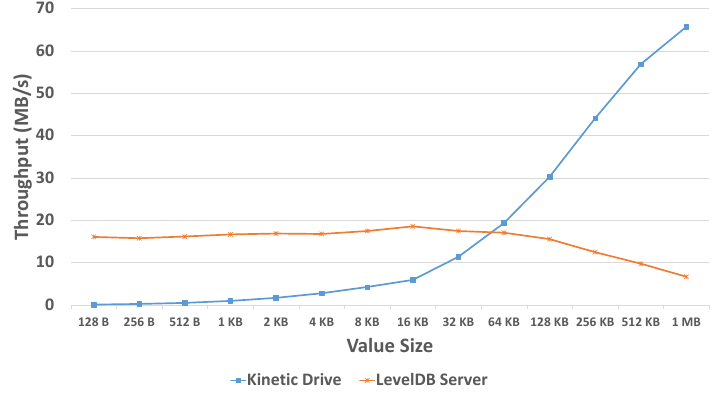
Figure 3. Comparison of sequential write throughput between the Kinetic Drive and the LevelDB server ( Key size = 16 B, one million key-value pairs)